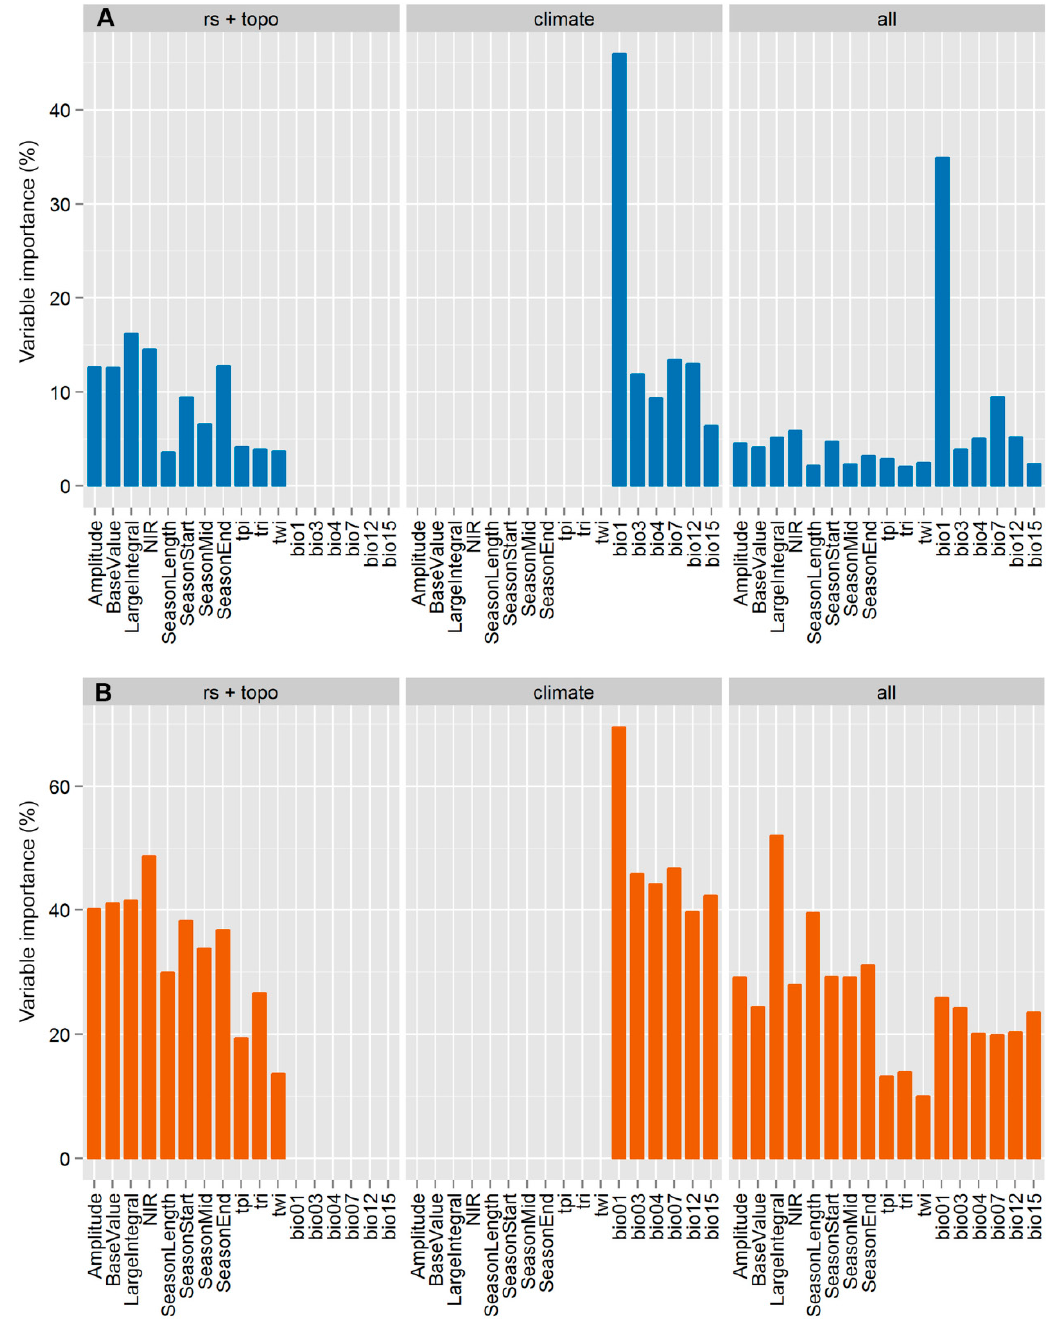
Figure 3. Variable importance for the two model types: ( A ) BRT, calculated as the relative influence (%); ( B ) RF, calculated as the increase in MSE (%). As the calculation of variable importance differs among BRT and RF, only the ranking of the variables can be compared, but not the absolute values.